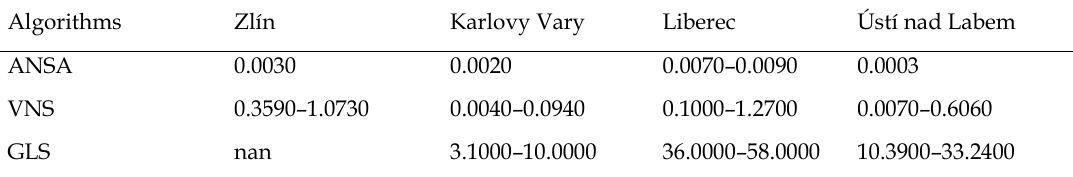
Table 3. Optimality of the results (in percentages).